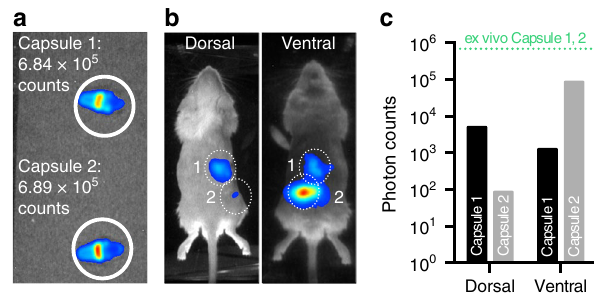
Fig. 1 Challenges in bioluminescence imaging. Planar in vivo BLi is qualitative or semiquantitative. a Capsules 1 and 2 with equivalent CFUs (10 8 ) of lux-bacteria. b In vivo BLi of capsules implanted at different locations inside an animal yields c different light intensities (photon count) at the tissue surface dependent on capsule location and camera